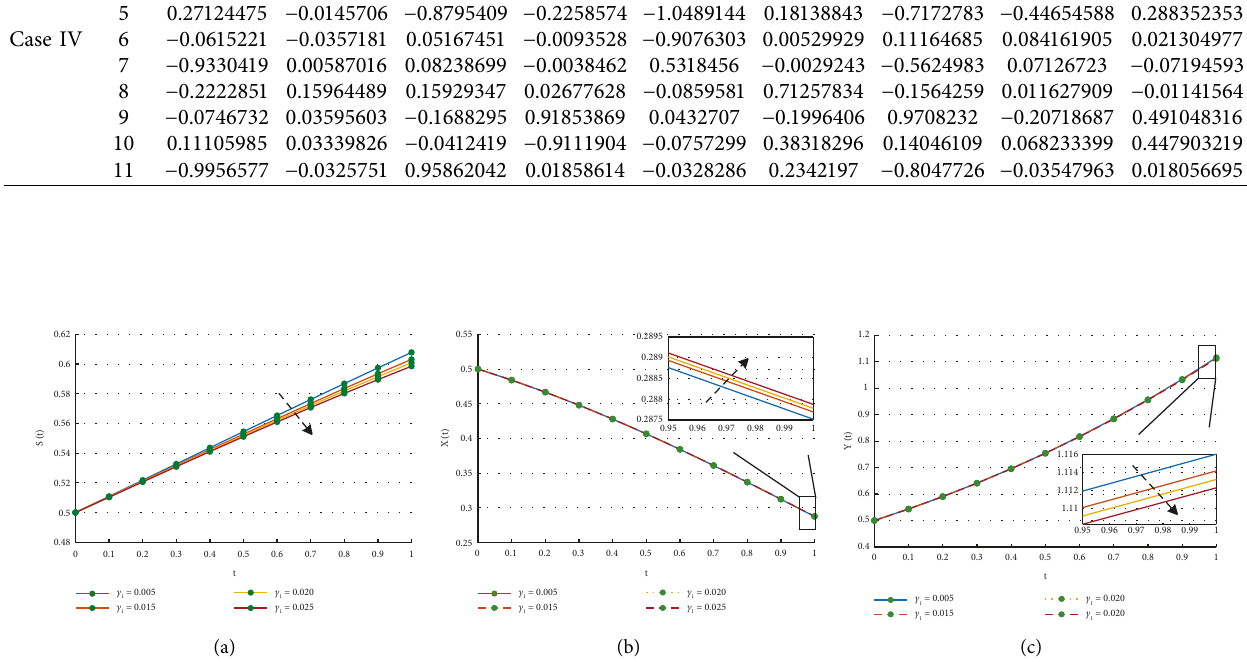
Figure 18: Comparison between solutions obtained by the LeNN-WOA-NM algorithm under the influence of variations in c population densities of the prey-predator model. (a) Approximate solutions for population density of local prey. (b) Approximate solutions for population density of immigrant prey. (c) Approximate solutions for population density of the predator.